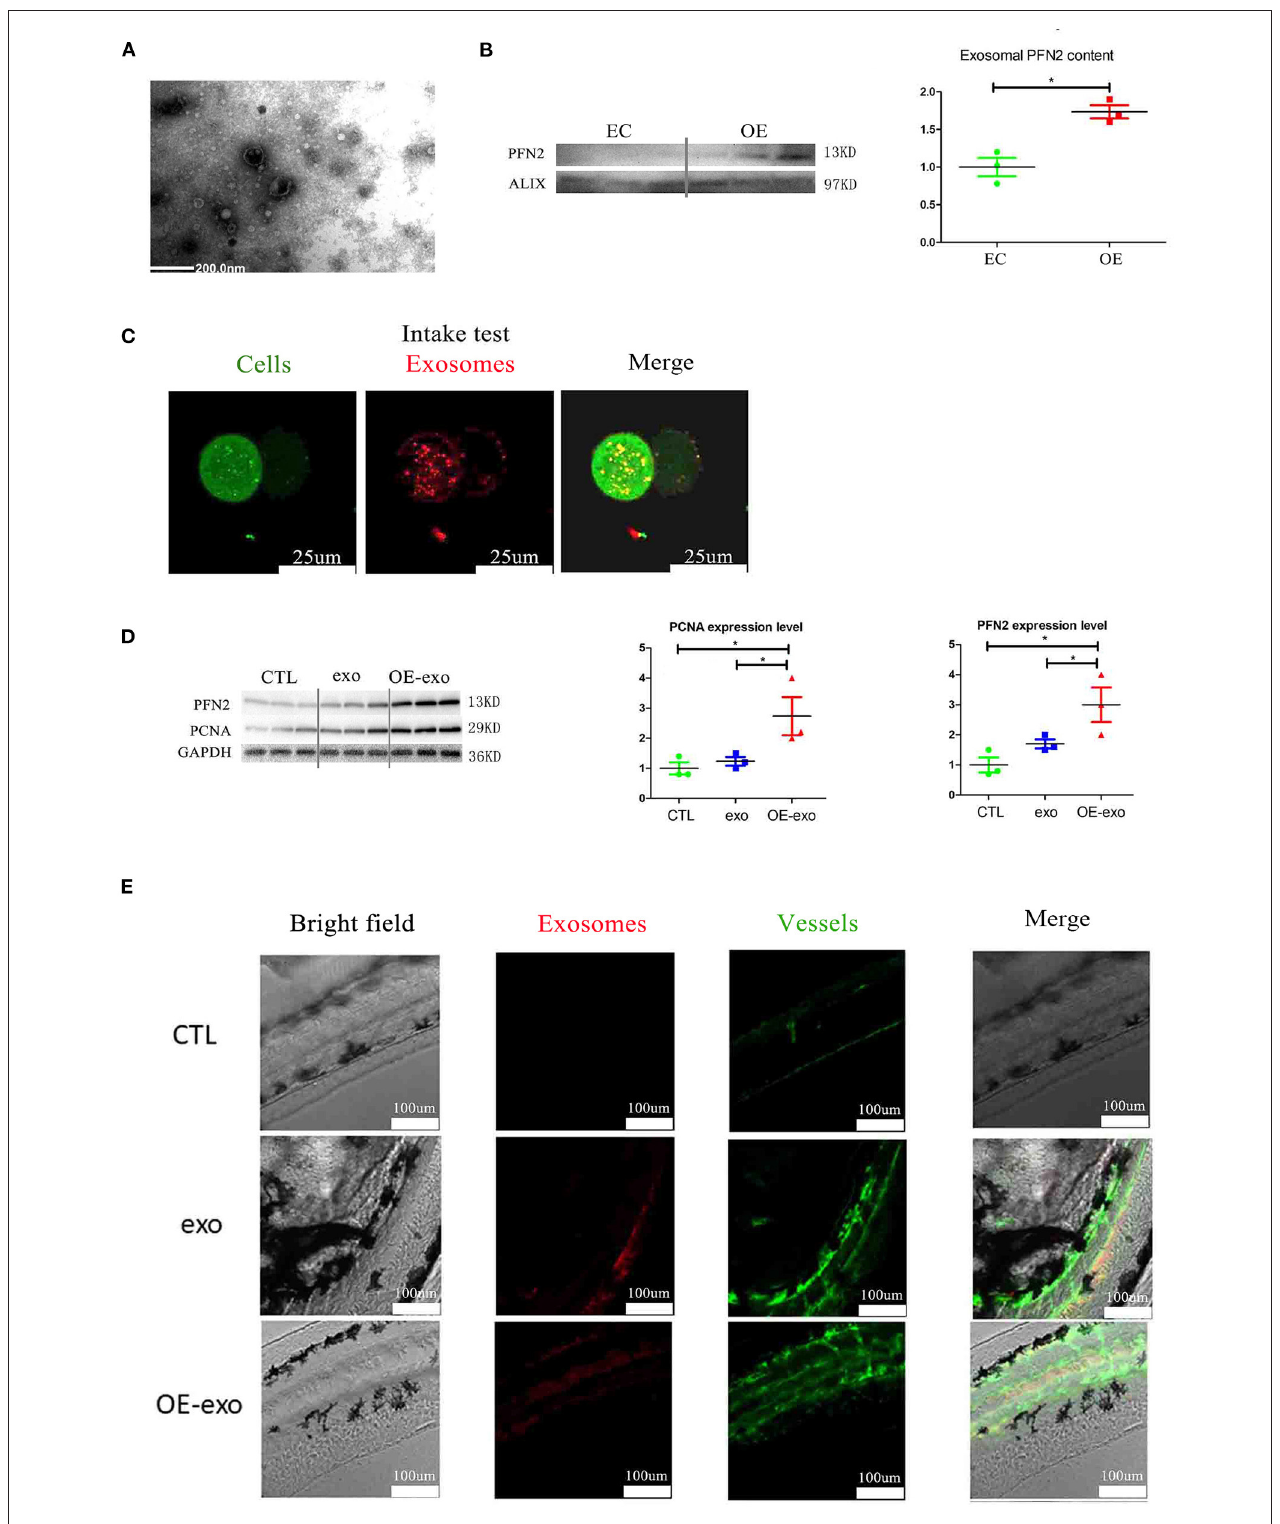
FIGURE 4 | Exosomal PFN2 enhances the proliferation ability of ECs and OE-exo treated zebrafish showed significantly increased vessel number than exo and control. (A) The exosomes secreted from ECs were identified by electron microscopy. (B) PFN2 expression in exosomes ( n = 3, the expression levels were